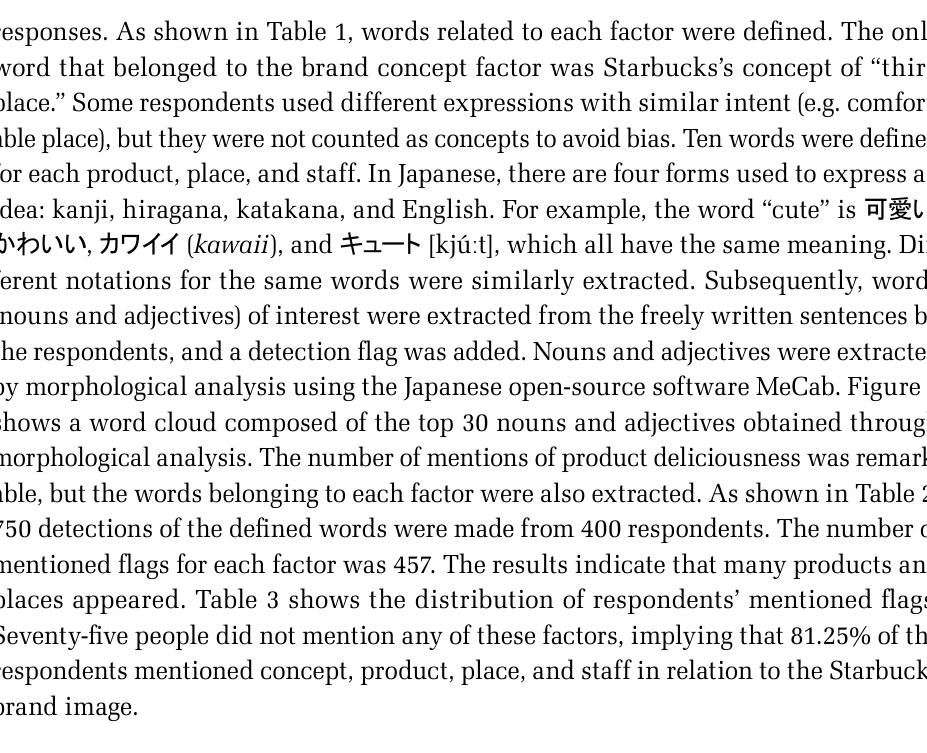
Table 1. Words to be detected in each factor